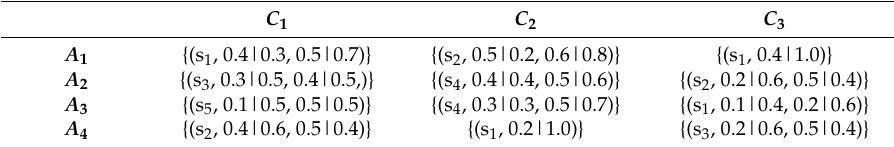
Table 1. Hesitant probabilistic fuzzy linguistic (HPFL) decision matrix (cid:102) H 1 provided by D 1 .